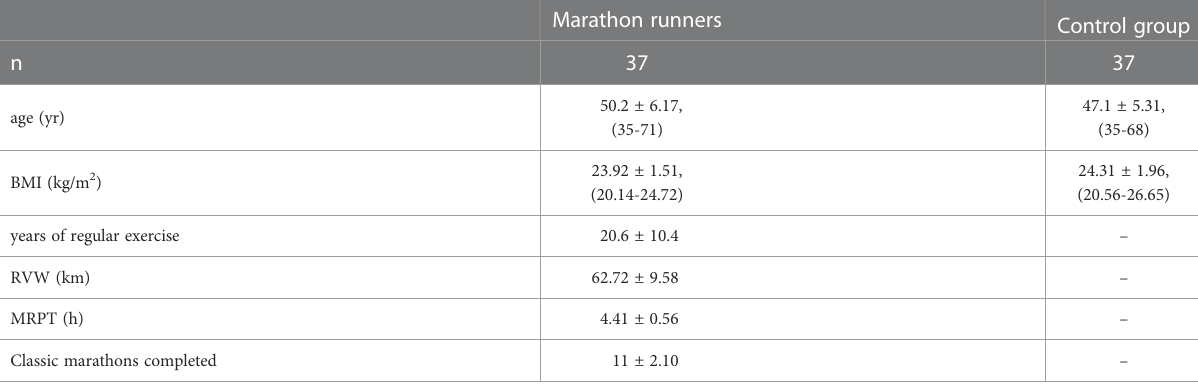
TABLE 1 Characteristics of the study